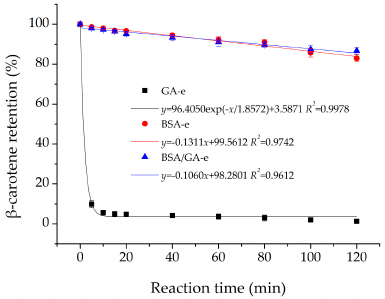
Figure 5. The effects of NaClO on the β -carotene retention of the three emulsions studied. The β -carotene retention of the three emulsions studied were measured after the reaction for 0, 5, 10, 15, 20, 40, 60, 80, 100, 120 min. Each data point is an average of triplicate, and the standard deviations are given. Solid lines represent the fitting results from the linear (BSA-e and BSA/GA-e) and exponential (GA-e) equation using OriginPro.